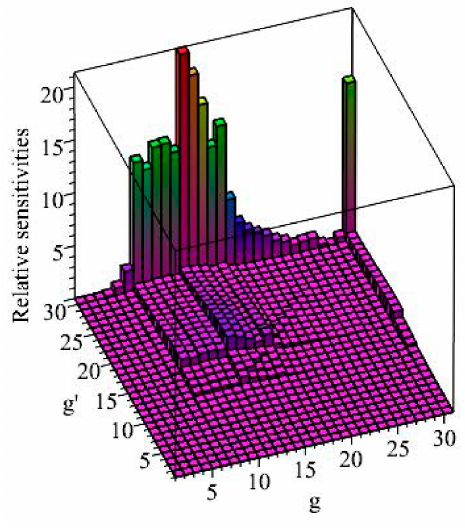
(cid:16) (cid:17) (cid:48) σ g , σ g , g , g (cid:48) = 1, ... ,30, for 239 Pu and 1 t , i = 1 t , k = 6